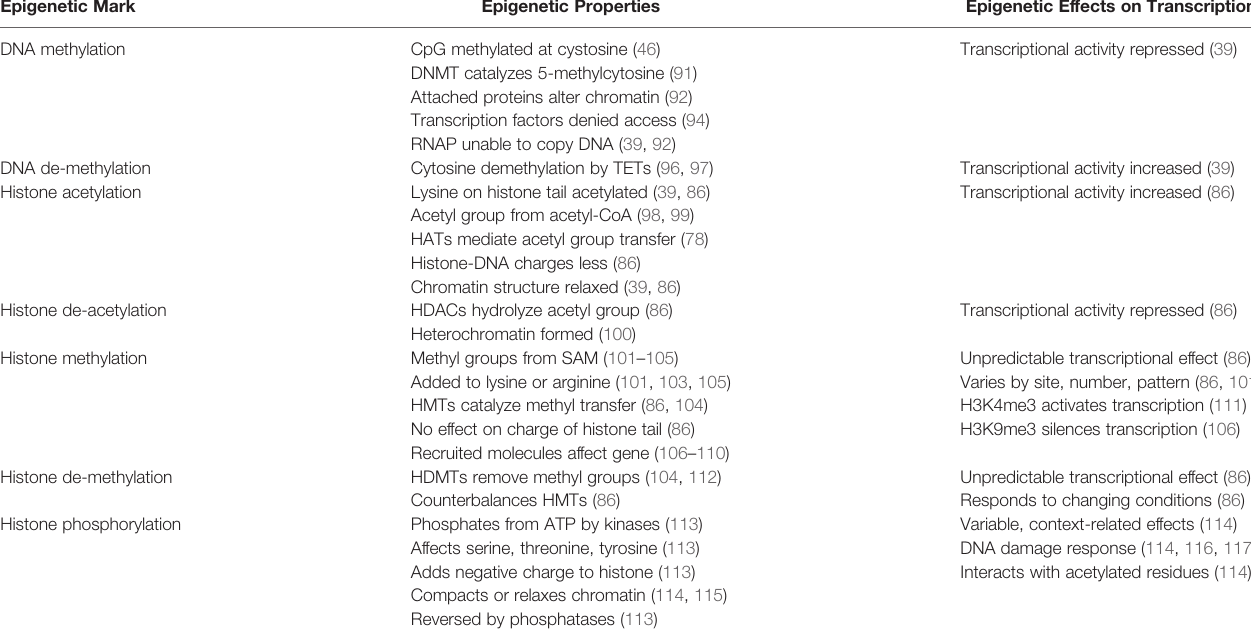
TABLE 1 | Epigenetic properties and effects on gene